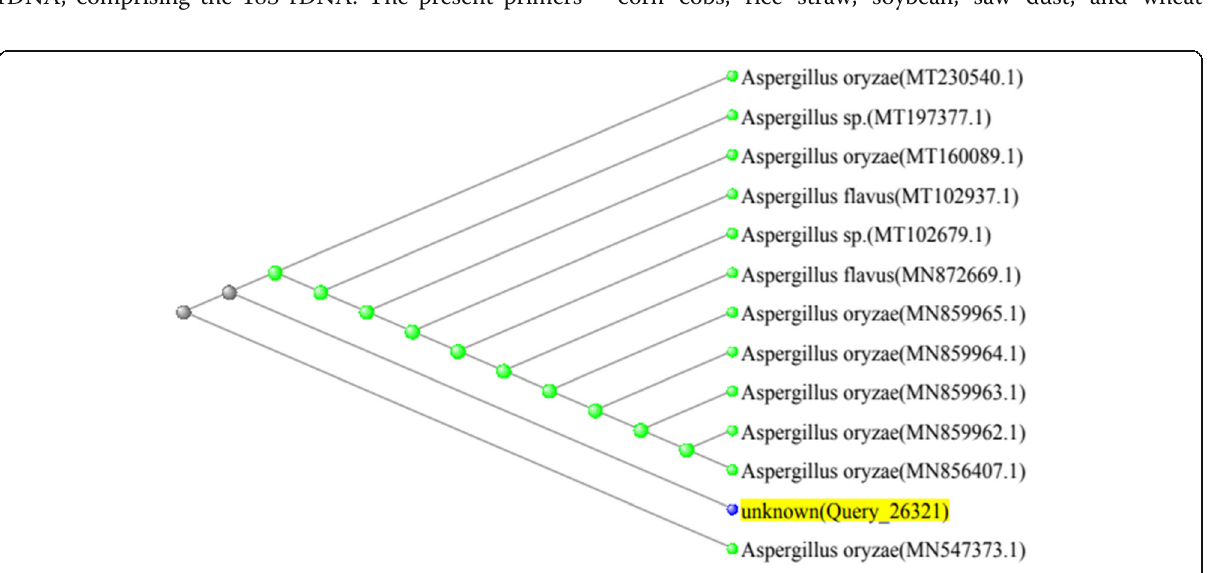
Fig. 1 Phylogenetic relations of Aspergillus oryzae SS_RS-SH and intimately correlated species from the GenBank list, based on 18S rDNA sequence